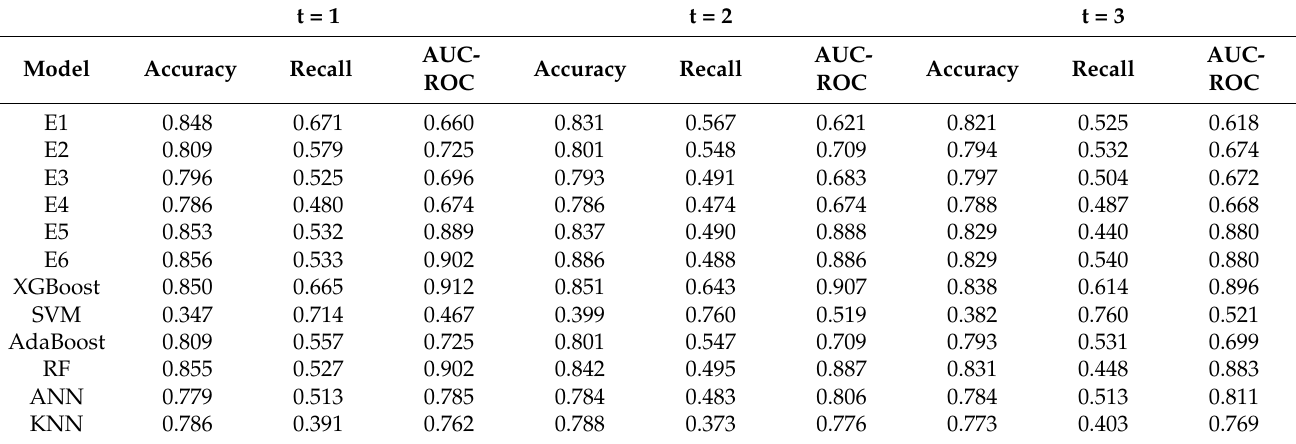
Table 8. Detailed results of model evaluation using 12 h of look back data and 1, 2, and 3 h prediction time.